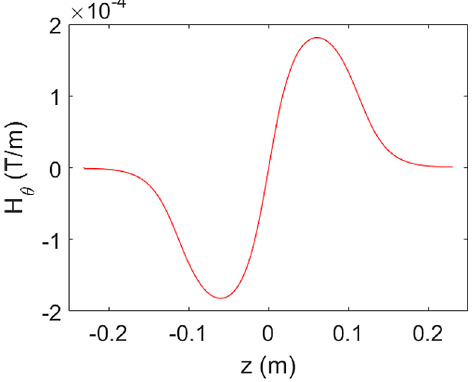
FIG. 15. Transverse component of the magnetic fields in the cavities.FIG. 12. Radial kick values for the horizontal trajectory offsets